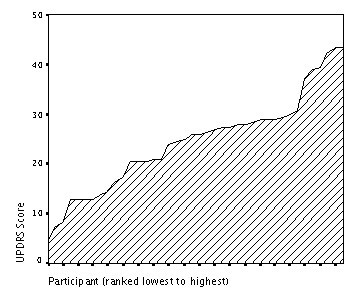
Area graph depicting range of motor impairment in the norming sample (40 patients, 40 controls).